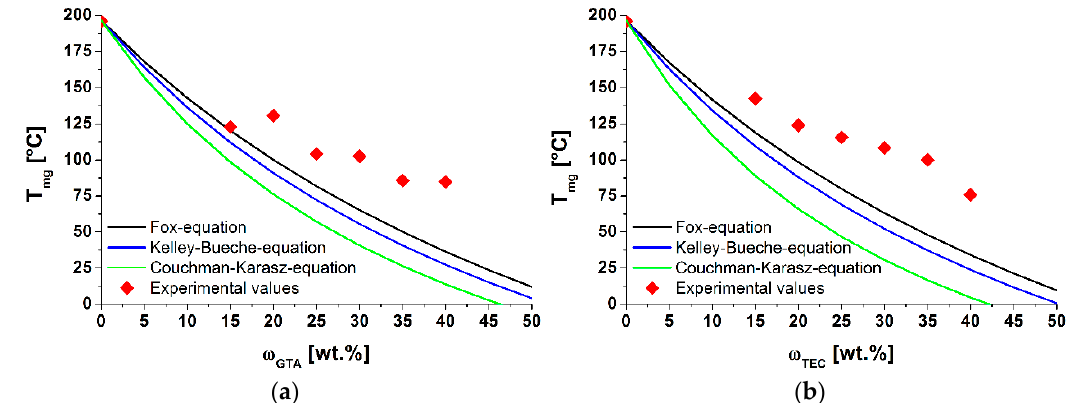
Figure 3. Experimental and theoretical values of the glass transition temperature for ( a ) GTA- (𝑘 = 2.66) and ( b ) TEC (𝑘 = 2.74) -plasticized CA.